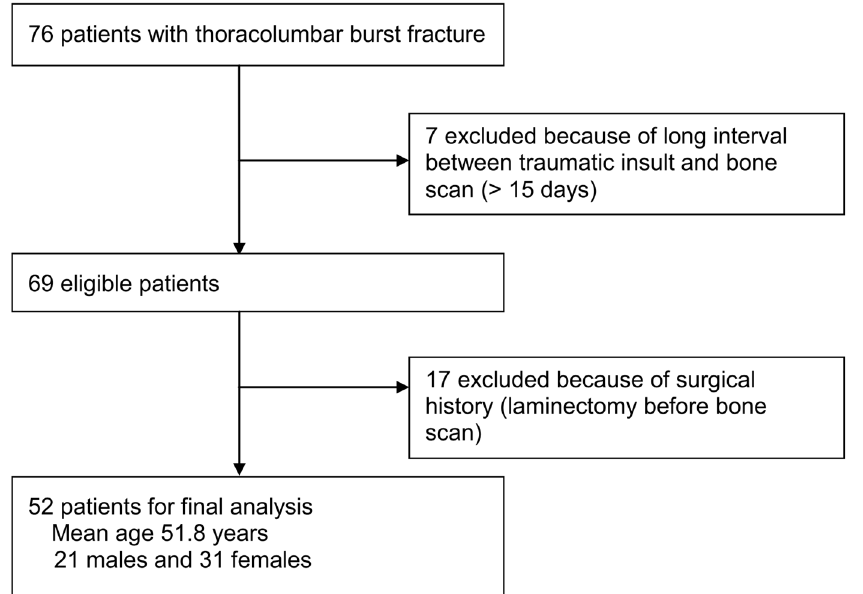
Figure 2. Flow diagram of the selection of patients with thoracolumbar burst fractures. Of the 76 patients who met the inclusion criteria, 7 whose bone scans were performed more than 15 days after trauma, and 17 who underwent laminectomy before scanning were excluded. A total of 52 patients were finally included in the study.